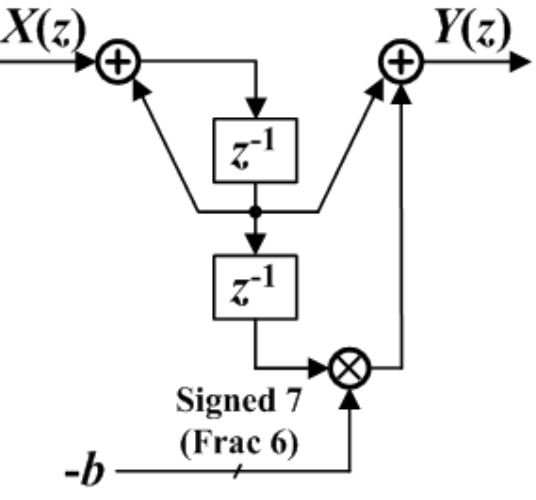
Figure 6. Loop filter L ( z )